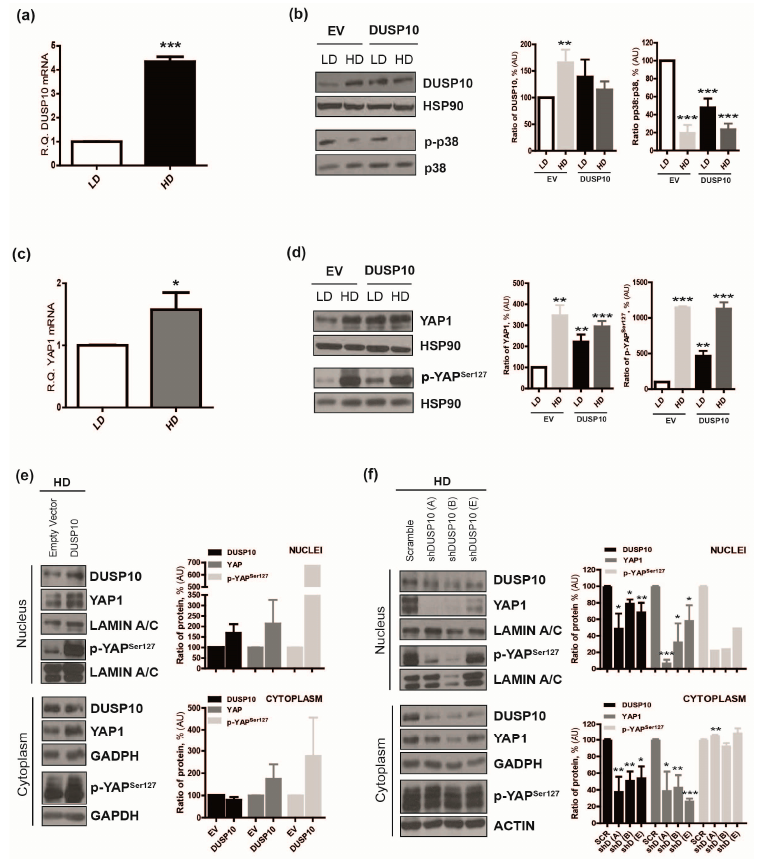
Figure 2. Nuclear DUSP10 and Yes-associated protein 1 (YAP1) are increased in high-density conditions. ( a ) DUSP10 mRNA was quantified by HT29 in low density (LD) and high density (HD). Student’s t -test (mean ± SEM; *** p < 0.001) and four independent experiments were performed. ( b ) Expression of DUSP10, p-p38, and p38 of HT29 in LD and HD. (Left) A representative image of five independent experiments. (Right) Quantification of blots performed (mean ± SEM; Student’s t -test; ** p < 0.01, *** p < 0.001). ( c ) YAP1 mRNA was quantified from HT29 in LD and HD. Student’s t -test (mean ± SEM; * p < 0.05) and three independent experiments were performed. ( d ) Expression of YAP1 and p-YAP Ser127 of HT29 in LD and HD. (Left) A representative image of five independent experiments. (Right) Quantification of blots performed (mean ± SEM; Student’s t -test; ** p < 0.01, *** p < 0.001). ( e ) Expression of DUSP10, YAP1, and p-YAP Ser127 proteins from nuclear and cytoplasmic extracts from HT29lucD6-DUSP10 and HT29lucD6-EV in HD. LAMIN A/C and GAPDH (glyceraldehyde 3-phosphate dehydrogenase) are nuclear and cytoplasm control proteins, respectively. (Left) A representative image of three independent experiments. (Right) Quantification of all blots performed (mean ± SEM; Student’s t -test; p < 0.05). ( f ) Expression of DUSP10, YAP1, and p-YAP Ser127 proteins from nuclear and cytoplasmic extracts of HT29lucD6-shDUSP10 and HT29lucD6-SCR in HD. LAMIN A / C and GAPDH / ACTIN are nuclear and cytoplasm control proteins, respectively. (Left) A representative image of three independent experiments. (Right) Quantification of all blots performed (mean ± SEM; Student’s t -test; * p < 0.05, ** p < 0.01, *** p < 0.001). Completed immunoblots of Figure 2b,d,e,f are in Figures S8 and S9,